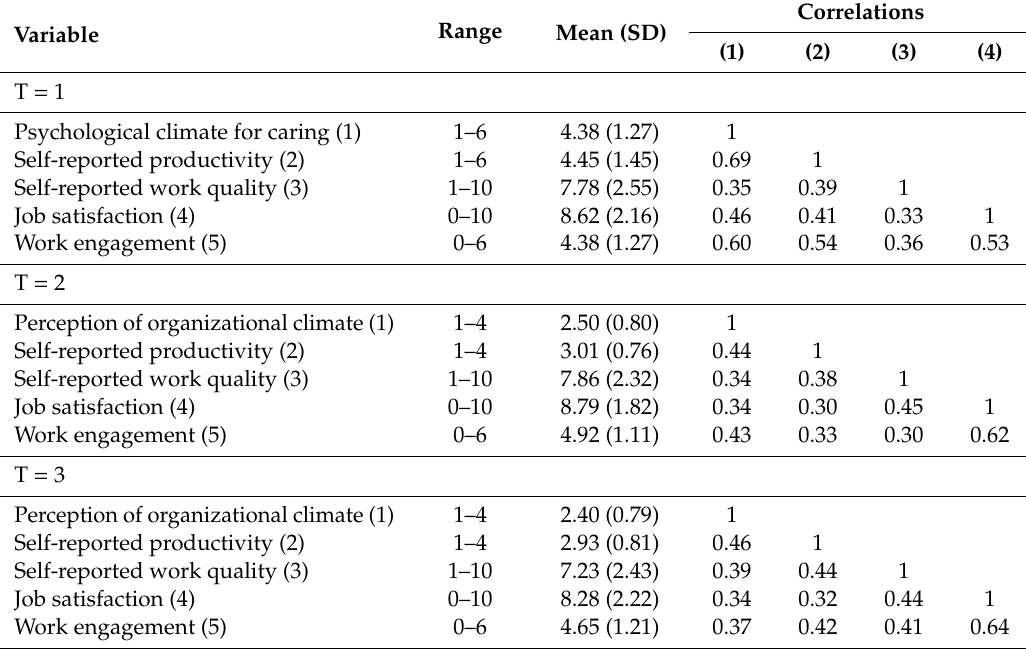
Table 2. Descriptive statistics and correlations between study